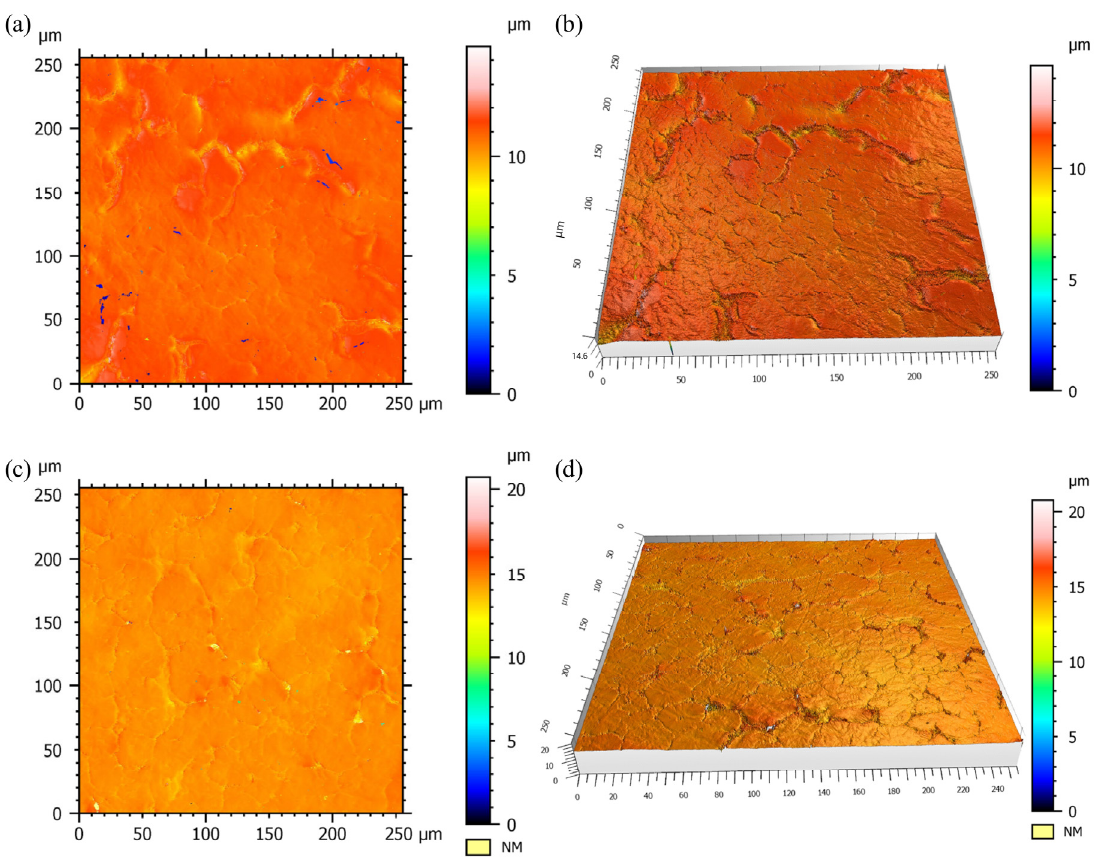
Figure 6. CLSM grain morphology of PP/GN nanocomposite at 13.79 MPa, ( a ) 2D-image and ( b ) 3D-image under 130 ◦ C, ( c ) 2D-image and ( d ) 3D-image under 140 ◦